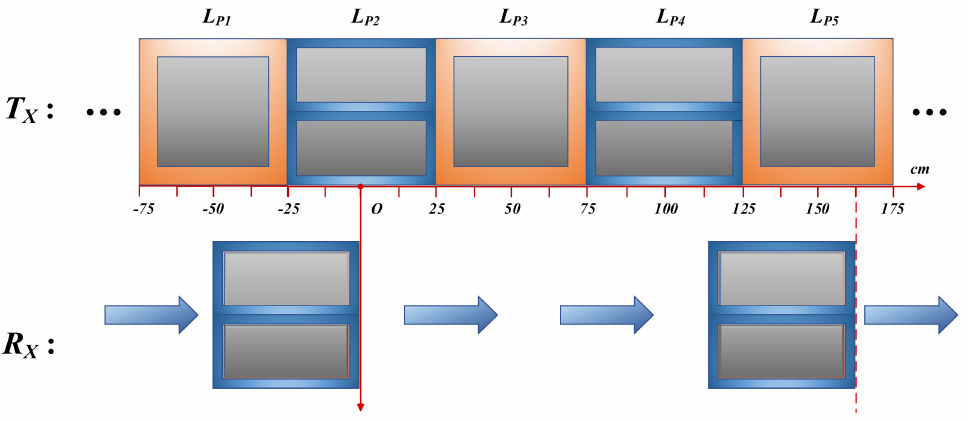
Figure 9. The stable charging zone.